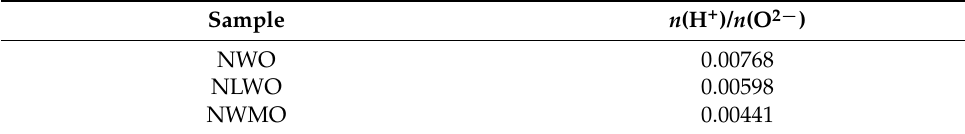
Sample n (H + )/ n (O 2 − )